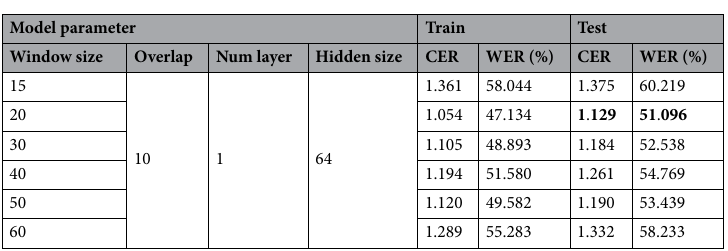
Table 4. Sliding window size tuning experiment result. Significant values are in [bold].